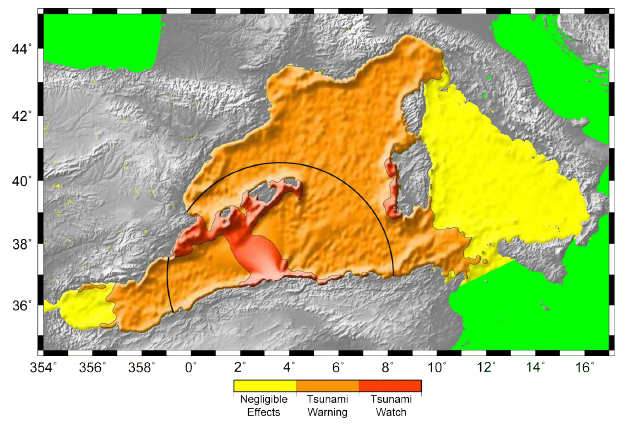
Fig. 8. Warning map resulting from the “on the fly” tsunami model- ing, using the source parameters of Yelles et al. (2004). Color scale same as Fig.